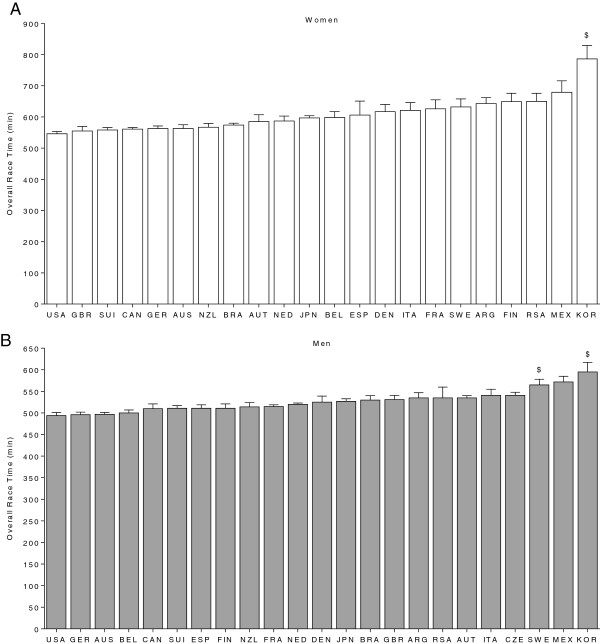
Overall race time of top ten finishers per country for women (Panel A) and men (Panel B). $ = significantly slower than next faster country. USA = United States of America, GER = Germany, JPN = Japan, AUS = Australia, CAN = Canada, SUI = Switzerland, FRA = France, GBR = Great Britain, NZL = New Zealand, AUT = Austria, BEL = Belgium, BRA = Brazil, ITA = Italy, ESP = Spain, NED = Netherlands, ARG = Argentina, DEN = Denmark, MEX = Mexico, RSA = Republic South Africa, SWE = Sweden, Fin = Finland, CZE = Czech Republic, KOR = Korea.